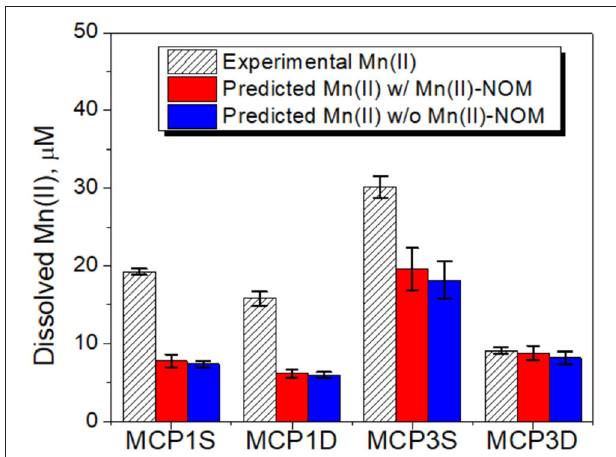
FIGURE 9 | Dissolved Mn(II) concentrations vs. predicted rhodochrosite solubility with and without including Mn(II)-NOM complex. The error bars represent one standard deviation from duplicate